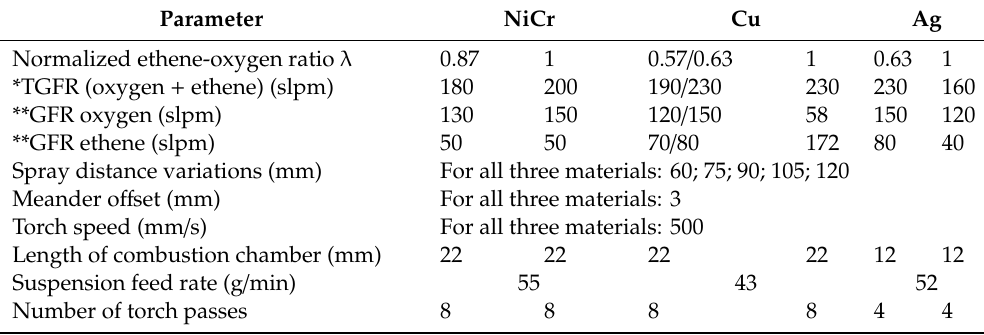
Table 2. Overview of the HVSFS spraying parameters discussed in this paper. Parameter NiCr Cu Ag Normalized ethene-oxygen ratio λ 0.87 1 0.57 / 0.63